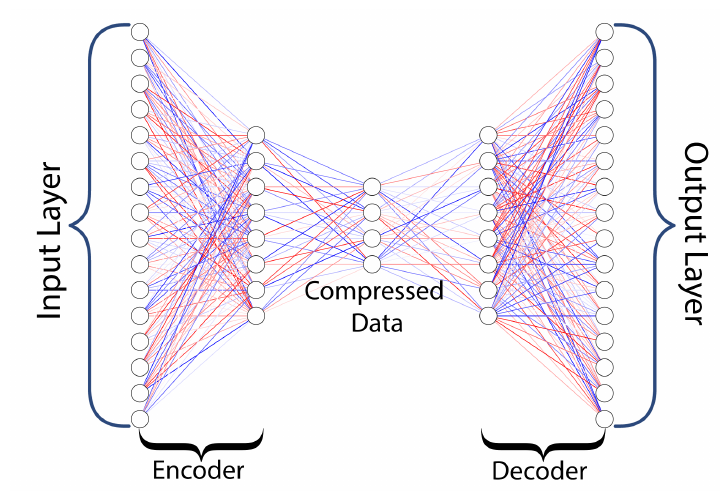
Figure 15. Basic Autoencoder